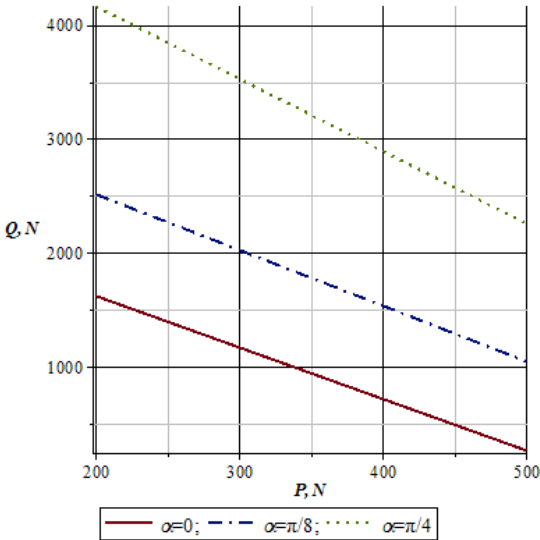
Figure 9. Graph of changes in the pressure of working rolls depending on their weight force.